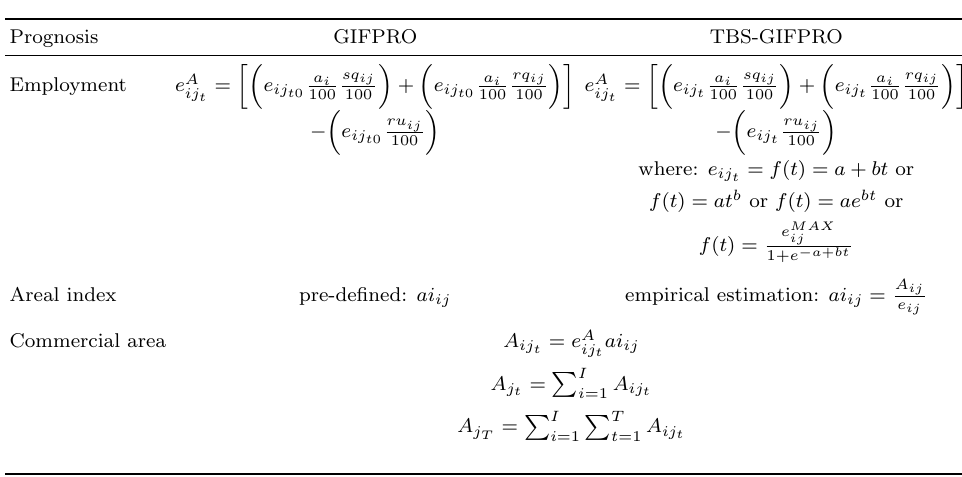
Table 13: Commercial area